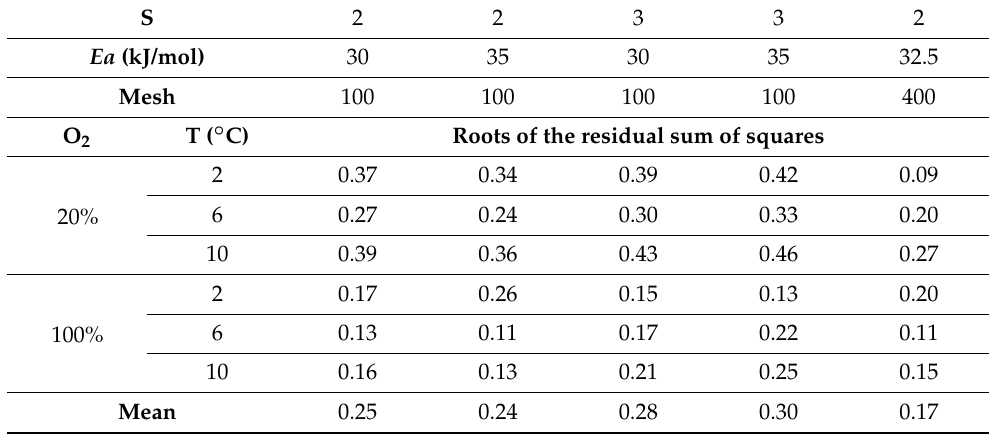
Table 1. Reaction–diffusion model quality of fit 1 for all environmental